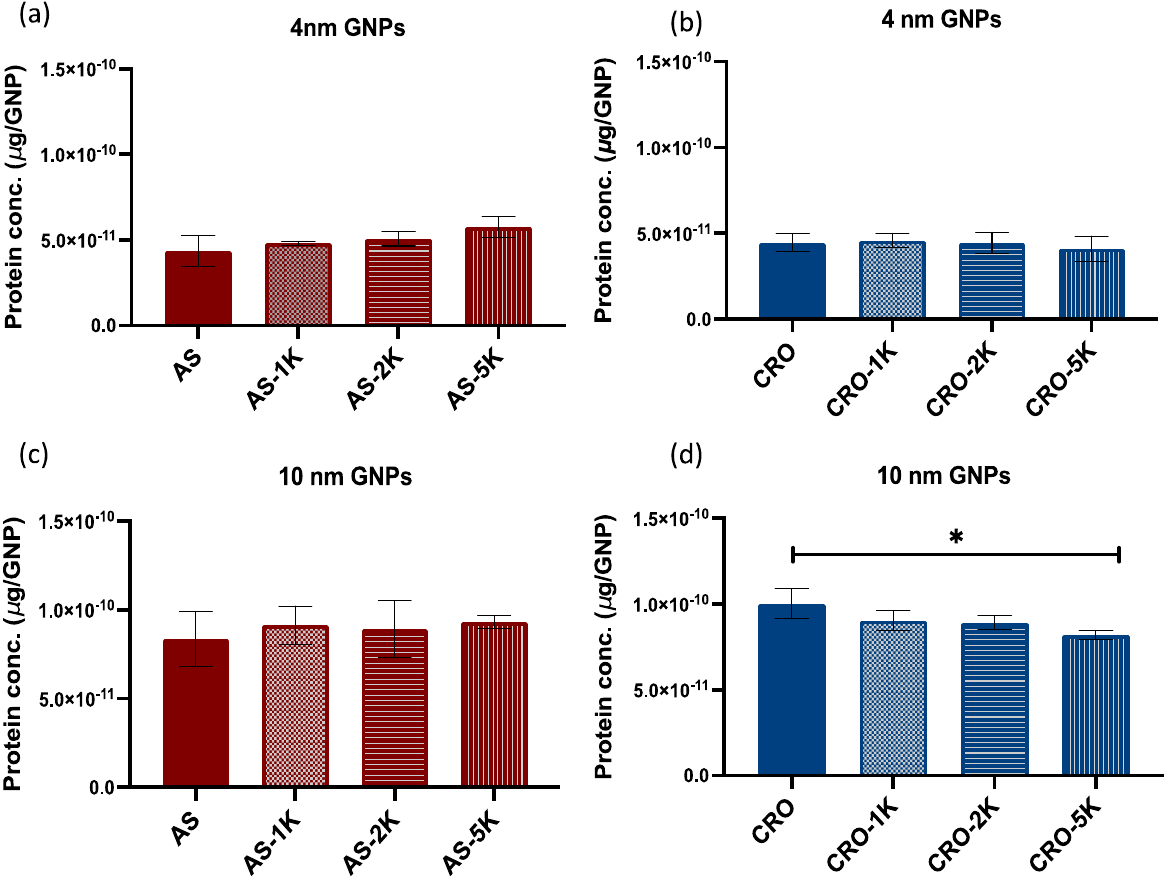
Figure 3. Quantification of the number of adsorbed proteins after incubation with 10% human se- rum. ( a ) 4 nm GNPs conjugated with AS1411. ( b ) 4 nm GNPs conjugated with CRO. ( c ) 10 nm GNPs conjugated with AS1411. ( d ) 10 nm GNPs conjugated with CRO. Each data point represents the mean ± standard deviation (SD) of triplicate experiments. * denotes p value < 0.05.